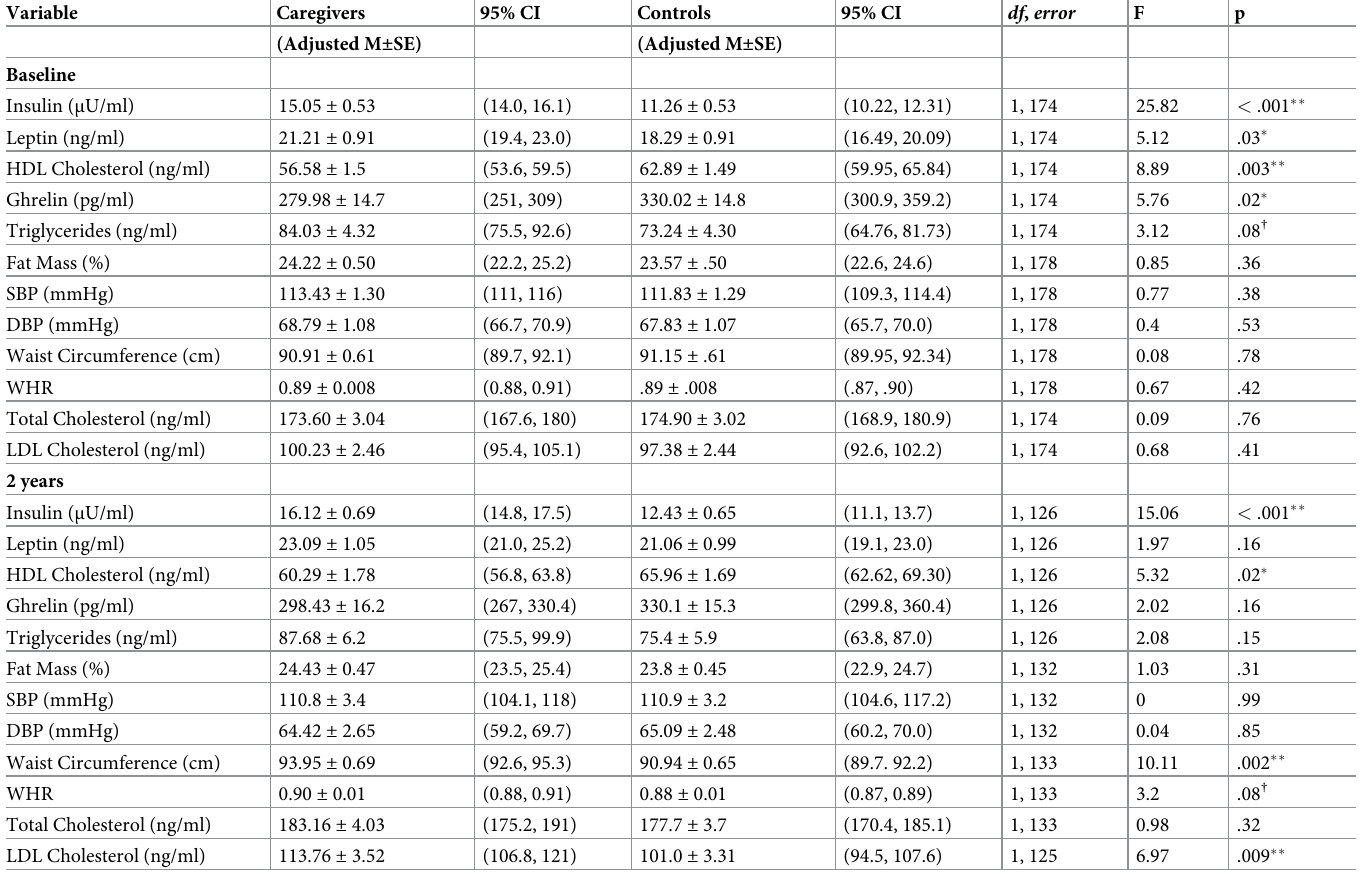
Table 4. Group differences in metabolic health (continuous variables) at baseline, adjusting for baseline BMI (top panel); and 2 years, adjusting for 2 year BMI (bot- tom